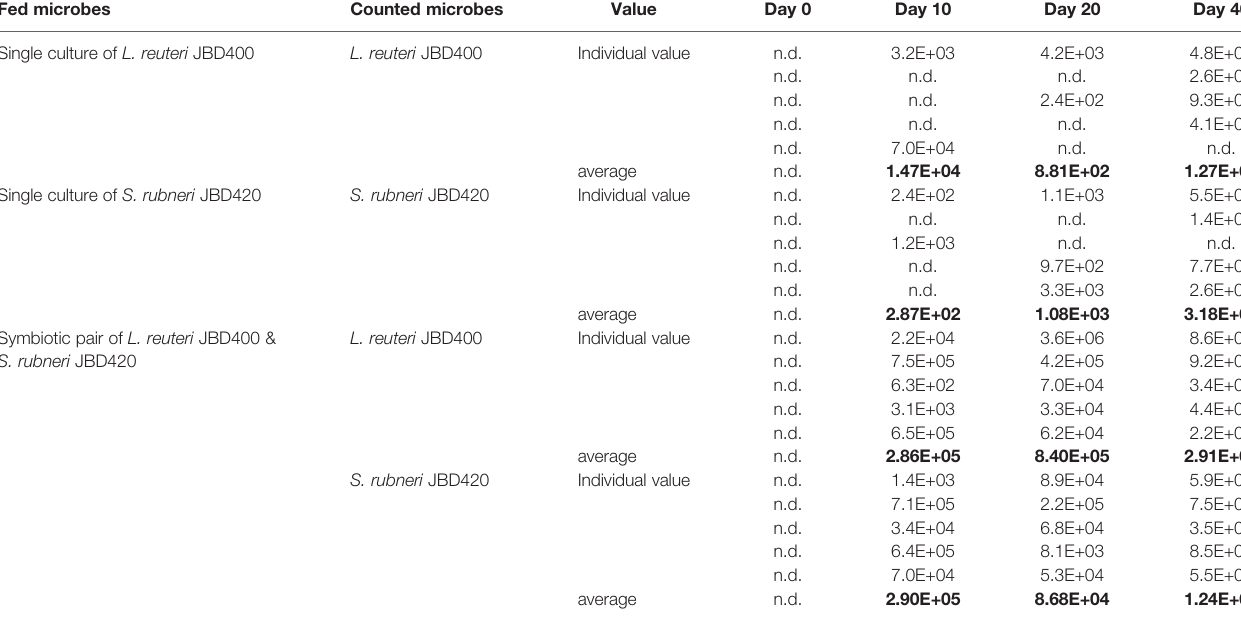
TABLE 1 | Comparative analysis of the transplantation ef fi ciency of L. reuteri JBD400 with the assistance of the symbiotic partner S. rubneri JBD420. Fed